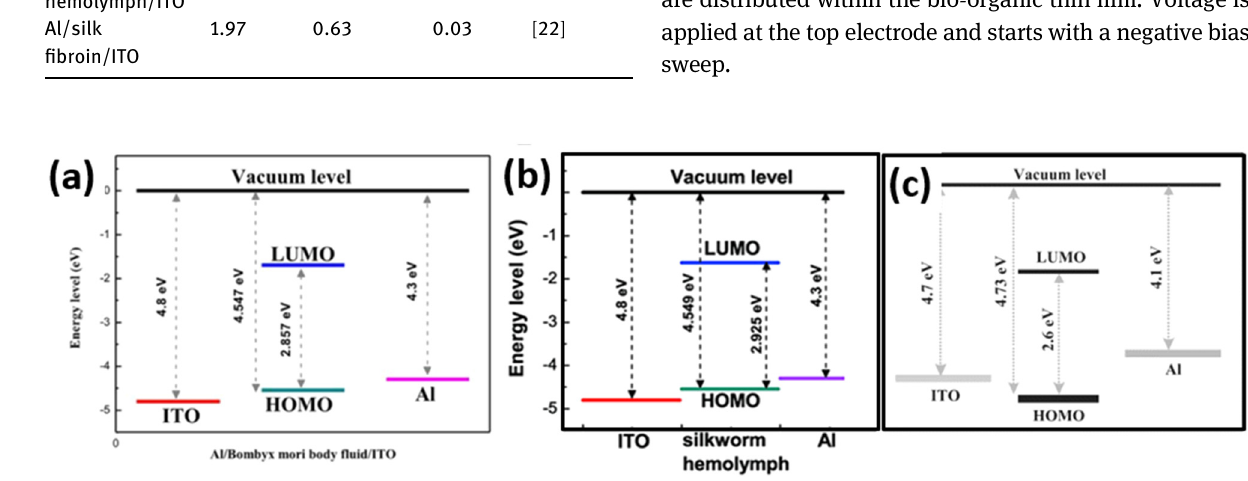
Figure 8: Energy band level and work function of the respective electrodes for ( a ) Bombyx mori body fl uid [ 31 ] , ( b ) silkworm hemolymph